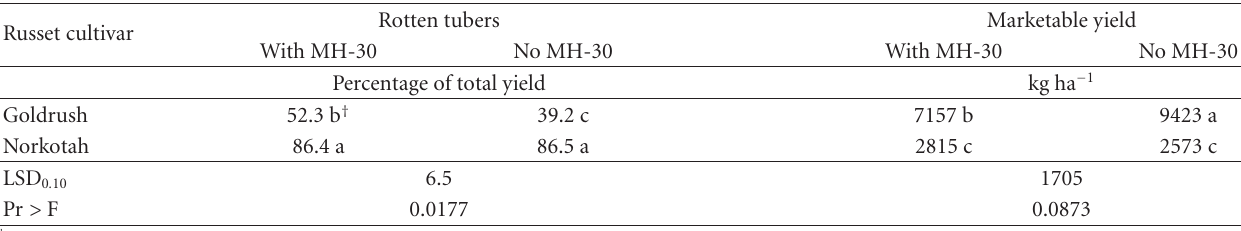
Table 8: Growth regulator (MH-30) × variety interaction in 2011 for rotten tubers as a percentage of total yield and marketable tuber yield for Russet potatoes grown on sandy loam soils in the Mid-Atlantic, averaged across Nrates and N application timing. Russet cultivar